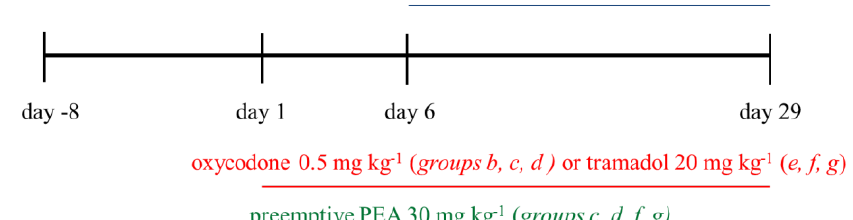
Scheme 1. Representative image of the first experimental treatment